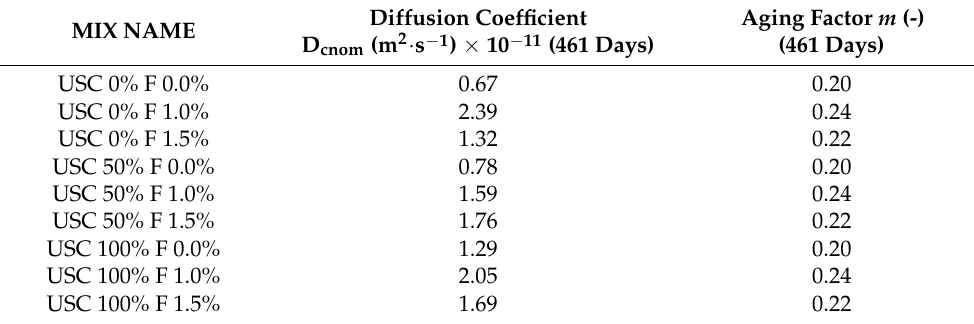
Table 6. Constant diffusion parameters measured at 461 days and the aging factor determined in time.